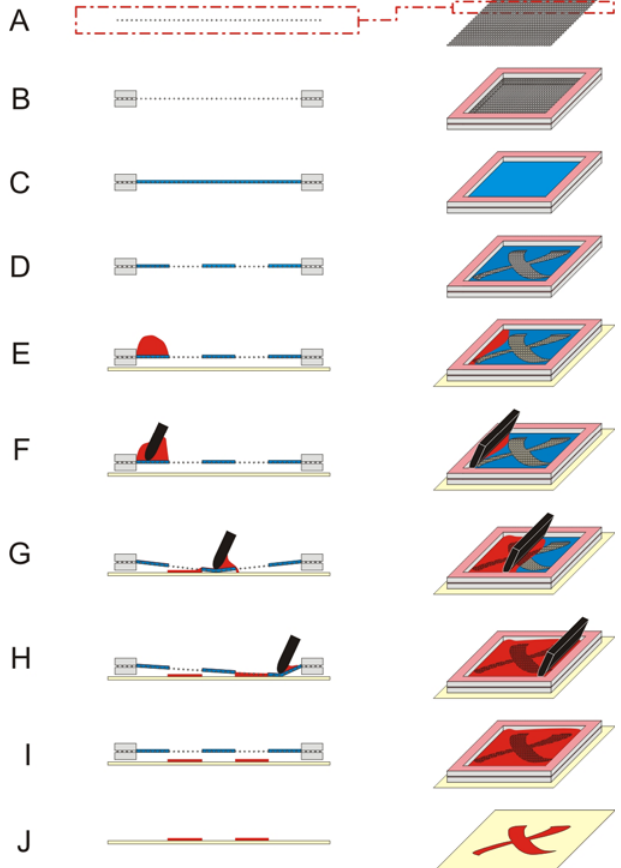
Figure 1. Fabrication of stencil (A-D) and printing process (E-J). A net made from steel or nylon (A) is mounted in a stiff frame (B) and covered with a photo-curable paint (C). After curing, the negative form of requested pattern creates on the net (D). Ready to use, the stencil is arranged on the top of a substrate to be covered and a paste is put on the stencil (E). Squeegee movement spreads the paste on the whole stencil’s surface (F-H). The paste goes through the openings in the stencil and covers the substrate in the requested way (I). Drying the printed pattern (J) finishes the whole